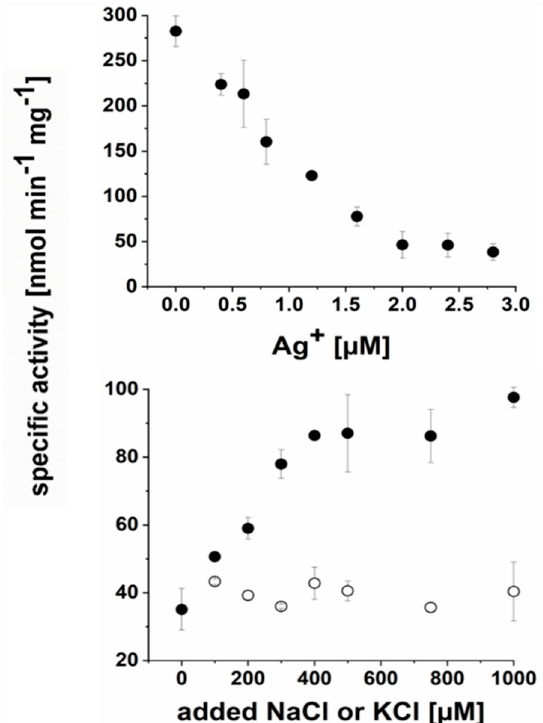
Figure 8. The Na + -translocating NADH:quinone oxidoreductase is the major membrane-bound NADH dehydrogenase in P. bivia . Assays were performed with solubilized membranes (50 µg of protein). Upper panel: NADH dehydrogenase activity at increasing [Ag + ] in chloride-free assay buffer. Lower panel: Q1 reduction activities at increasing [K + ] (open circles) or [Na + ] (closed circles). Residual Na + concentration of buffer was at ~10 µM. Average and standard deviations from two technical replicates are shown.